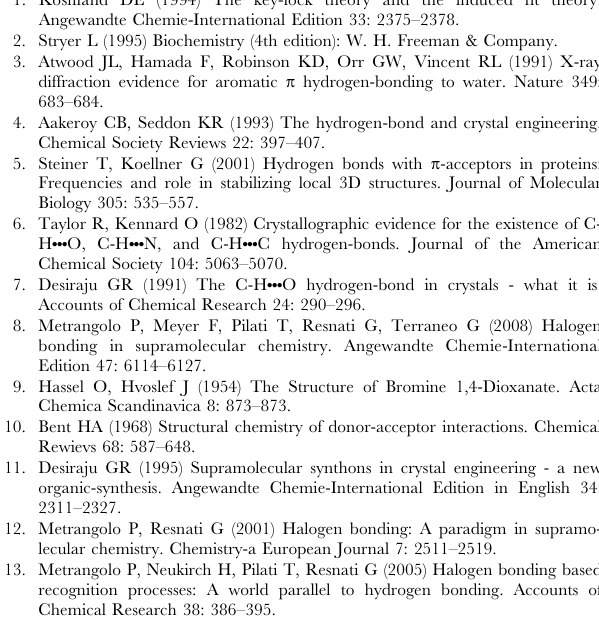
Figure S1 Cumulative distributions of donor-acceptor distanc- es determined for various types of intermolecular hydrogen bond donor-acceptor pairs identified In complexes of proteins with non-halogenated ligands, in which the ligand is either a hydrogen bond donor (A, C, E) or acceptor (B, D, F); determined for non-halogenated, LH, (A, B), fluorinated, LF, (C, D), and otherwise halogenated (i.e. not fluorinated), LX, ligands (E, F). Figure S2 Effect of a halogen atom on cumulative distributions determined for the donor-acceptor pairs determined for hydrogen bonds between ligand and protein backbone (carbonyl oxygen: A, C or amide nitrogen’’ B, D). The distributions estimated for